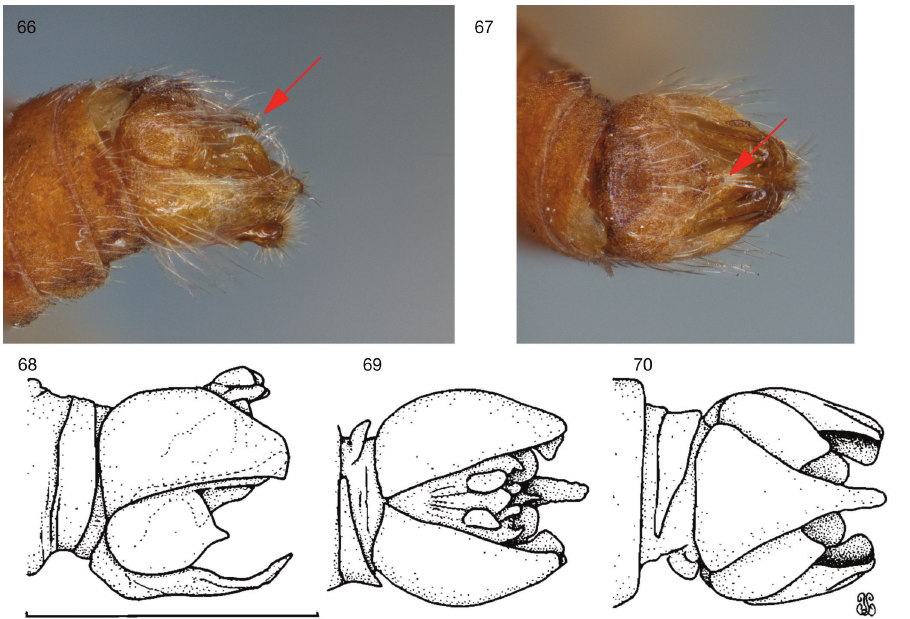
Wing : 3.1–3.7 mm. Abdomen : shape compressed, T2–3 distinctly transversely rectangular (length to width ratio > 1:3), orange to light brown, tergites smooth, setae with small sockets only; T1 white setose, postero-laterally long white macrosetose, white pubescent, anterior ½, except laterally, membranous, dorsal surface smooth, without protuber- ances; T2–8 entirely sclerotised, orange to light brown, white pubescent: in dorsal view T2–7 appearing predominantly apubescent except laterally, in lateral view T2–7 appearing apubescent in posterior ½ except lateral margin, short white setose, long white setose antero-laterally on T2, marginal macrosetae absent from T2–8, medial macrosetae absent from T2–8; S1–8 orange to light brown, lightly grey pubescent, short white setose. Female : T6–8 grey pubescent, setation directed anteriorly on T6–7 and dorsally on T8; postero-paramedian T8 pores present, indistinct, opening not elevated above tergite surface; T8 with internal rectangular apodeme (entirely fused to T) anteriorly; T10 divided into 2 heavily sclerotised acanthophorite plates, with 6–7, light brown acanthophorite spines per plate; 3 spermathecae, all equally large, reaching posterior end of segment 6; individual spermathecal ducts long; spermathecal reservoirs